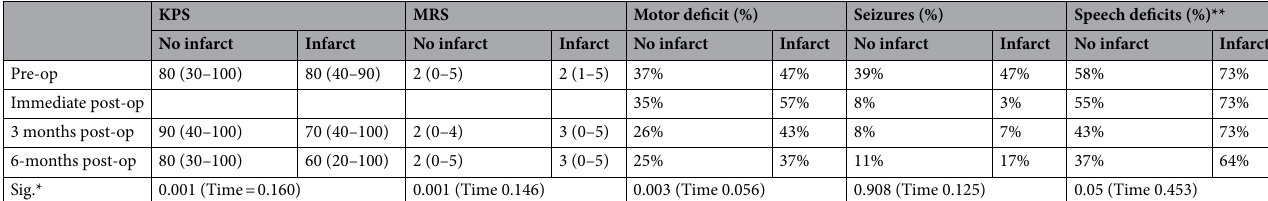
Table 4. Clinical outcomes in 239 HGG patients with (n = 30) and without surgery-related infarcts (n = 209). KPS Karnofsky performance status, MRS modified rankin scale. *Multivariate analysis for comparing infarct vs. non-infarct groups- Insular and temporal lesions. **Speech deficits analysis was performed in a subgroup of dominant side surgeries (n = 114), comparing infarct (n = 11) vs. non-infarct groups (n =